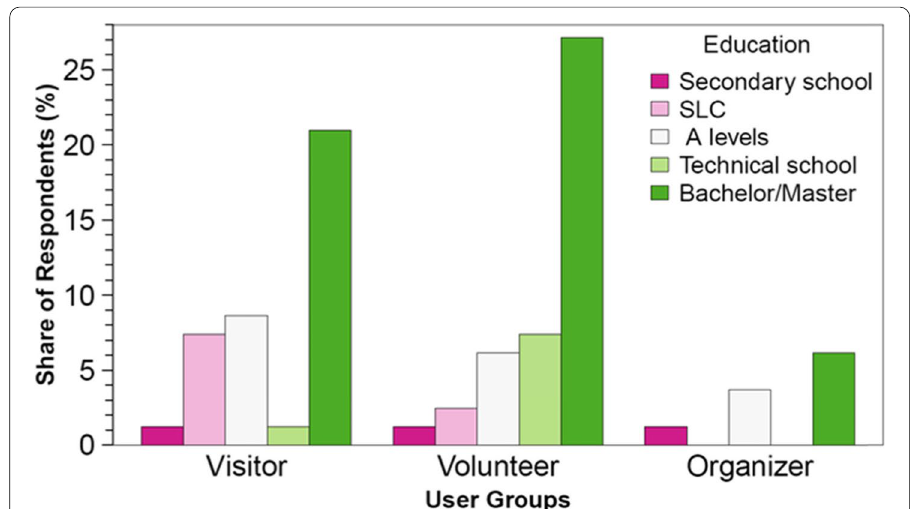
Fig. 2 Education attainment by share of respondents and user group